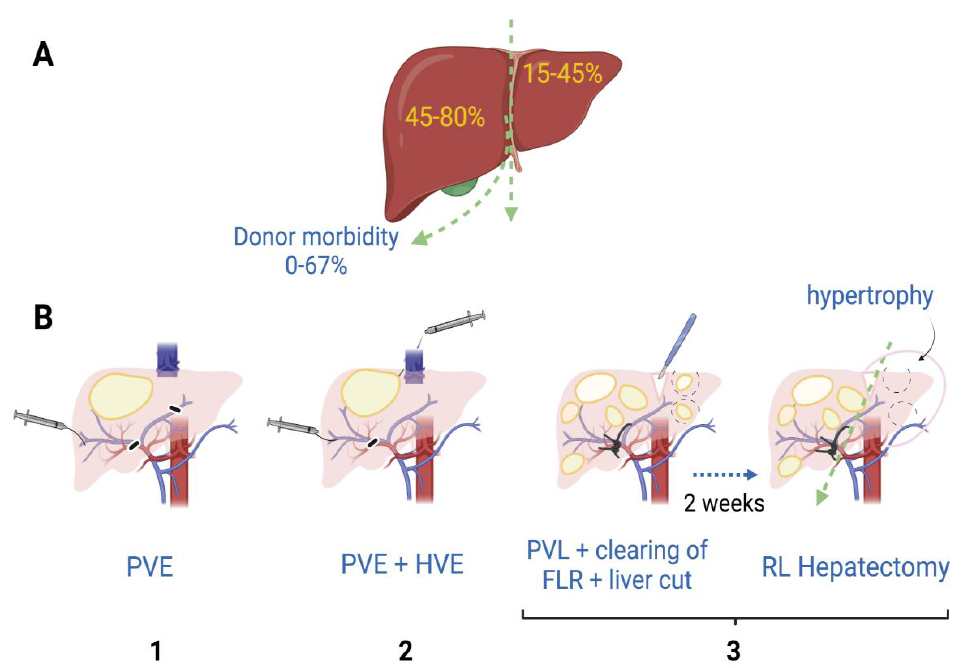
Figure 2. Hepatectomy of the right lobe is implicitly riskier. ( A ) The right lobe represents, on average in healthy humans, 45–80% of the whole liver volume [37], while morbidity of right lobe donors is estimated to be 0–67% [38]. ( B ) When the right lobe is compromised for the presence of one or more tumors, patients might need extensive hepatectomy. To minimize small-for-size syndrome risks and promote hypertrophy of the left lobe, liver surgeons have practiced some of these procedures previous to the right lobe hepatectomy: (1) Right portal vein embolization (PVE) by introducing occlusive materials (e.g., ethanol, microparticles); (2) Simultaneous embolization of portal and hepatic veins (HVE); (3) In cases where left lobe also has tumors, portal vein ligation (PVL) together with ablation of left lobe tumors (clearing of future liver remnant; FLR) and liver transection have been performed. After 1–2 weeks, once left lobe shows hypertrophy, a right lobe (RL) hepatectomy can be performed [35].